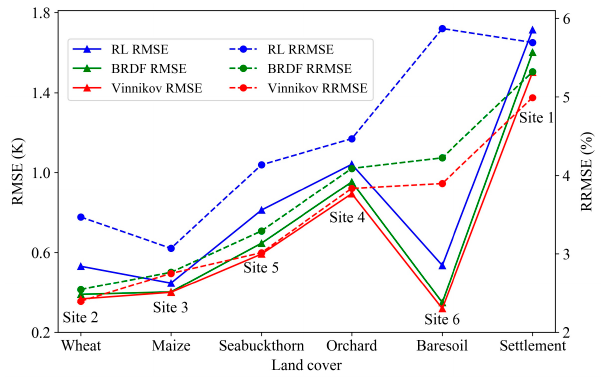
Figure 6. RRMSE of anisotropy fitting error for each site using the airborne dataset.